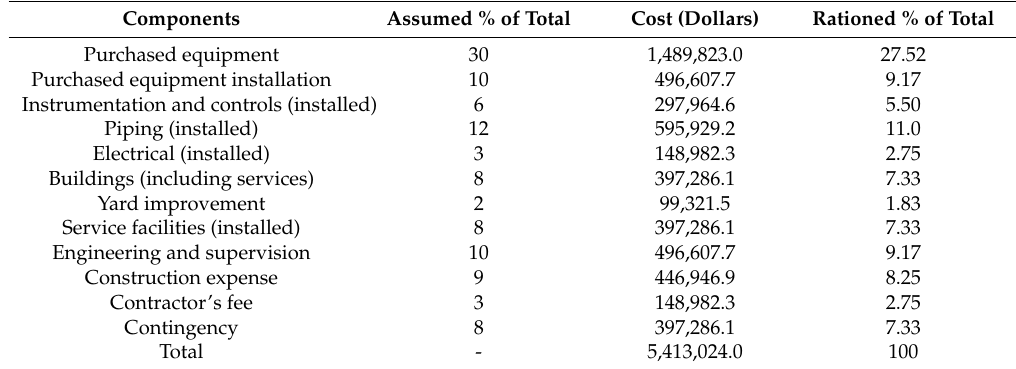
Table 8. Fixed capital investment costs [26].